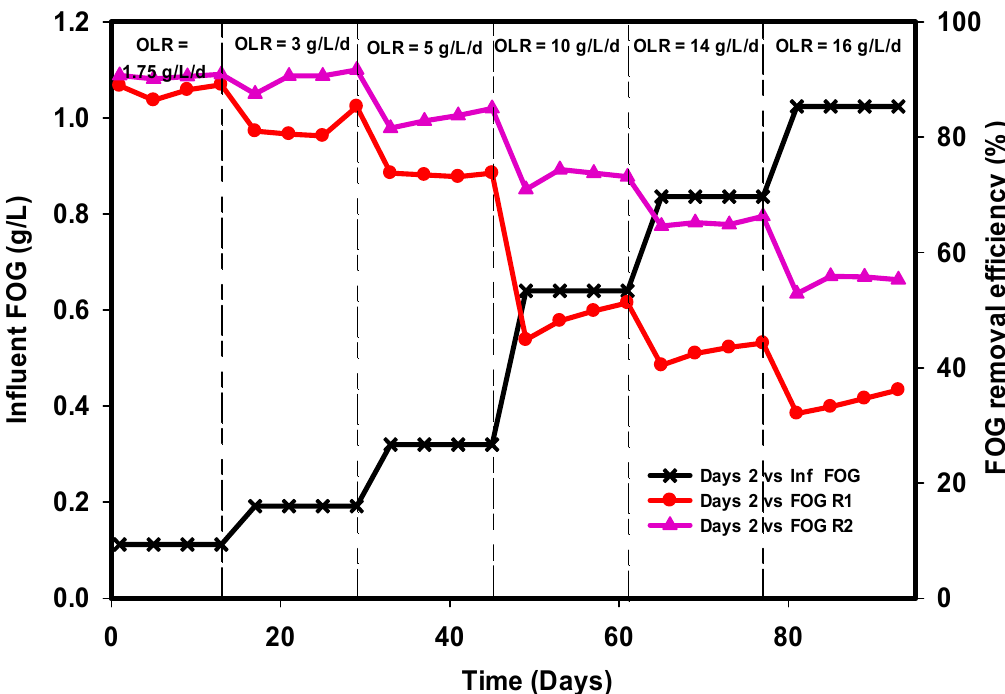
Figure 5. Comparison of fats, oil, and grease removal efficiencies of R1 and R2.